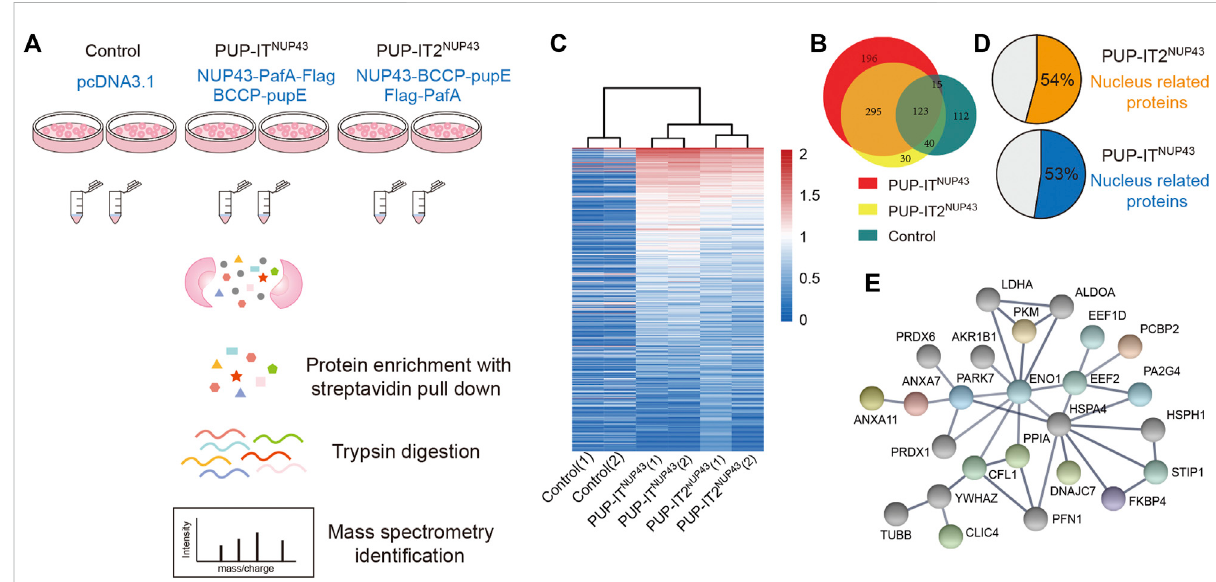
FIGURE 4 PUP-IT2 is as ef fi cient as PUP-IT for cellular labeling. (A) The work fl ow of PUP-IT2 based proximity labeling to identify interacting proteins. (B) Theproteinsidenti fi edbyPUP-IT NUP43 orPUP-IT2 NUP43 proximitylabeling.Therelativeabundanceofproteinsidenti fi edbyPUP-IT NUP43 ,PUP-IT2 NUP43 or control isdepicted inthe Venn diagram. (C) Proteins identi fi ed byPUP-IT NUP43 , PUP-IT2 NUP43 or control is depicted inthe Heatmap diagram based onmassspectralcounts.ThecolorschemerepresentsthenormalizedMScountchangesinlogscale. (D) Apiechartshowingthepercentageof nucleus-associated proteins. The subcellular localization of proteins with a MS count 9 times higher than that of the control group were used for SRING gene ontology (GO) analysis. (E) STRING protein association network analysis of the nucleus-related proteins identi fi ed with PUP-IT2 NUP43 . The colored dots represent proteins, for which nuclear localization is suggested by